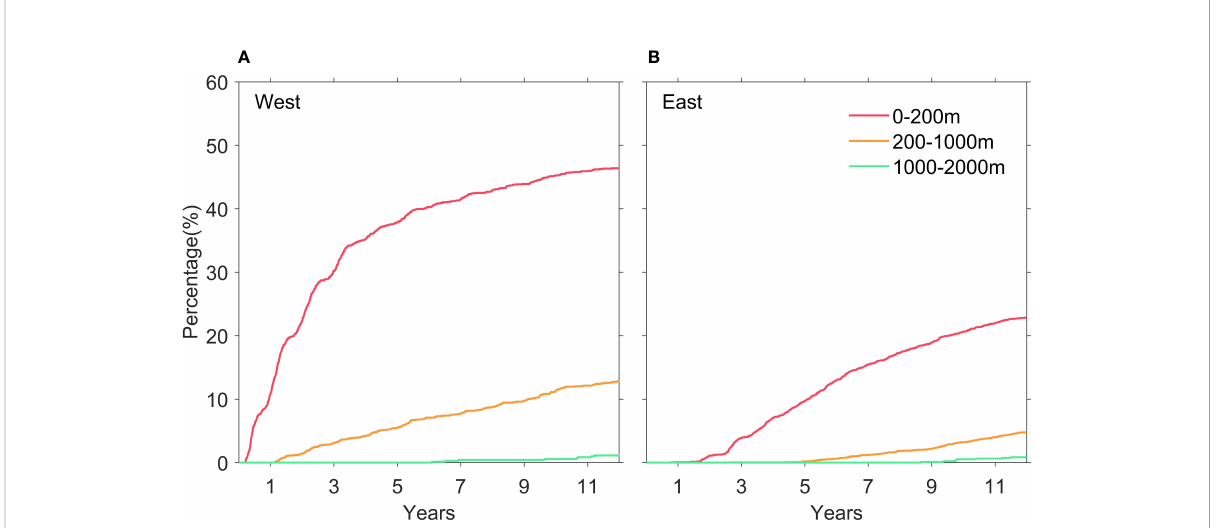
FIGURE 5 Transit time for particles to travel from different sources ( A , west of southern boundary at 10°N in the Arabian Sea; B, east of southern boundary at 10°N in the Arabian Sea) to the central Arabian Sea. The percentage of transit time represents proportion of particles to the number of particles in the water layer where they are located. The transit time of particles, de fi ned here as the time when half of the particles in the same water layer reach the central Arabian